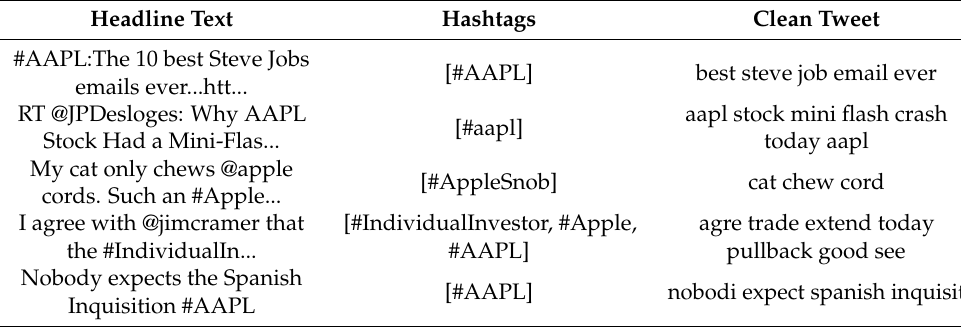
Table 2. Dataset structure after cleaning and separating